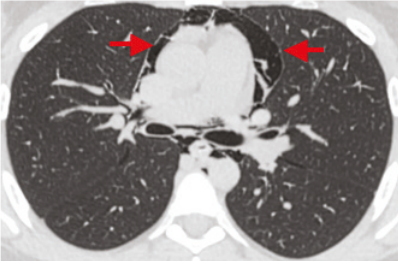
Figure 2: CT scan reconfirmed pneumomediastinum and subcuta- neous emphysema and ruled out esophageal injury.